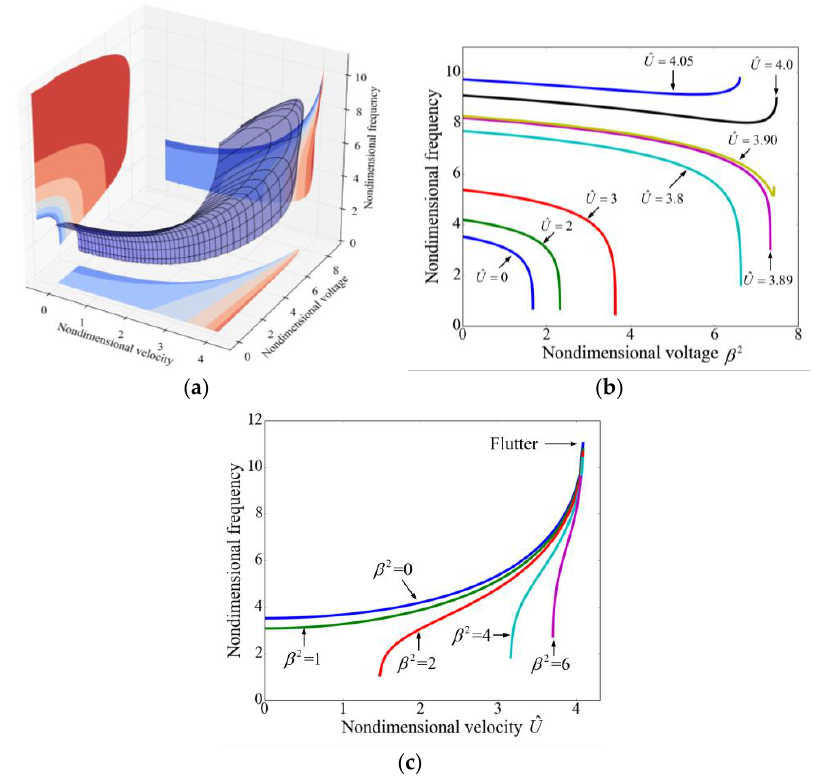
Figure 7. The variation of the fundamental frequency with the nondimensional voltage and the nondimensional velocity. ( a ) The effect of both applied voltage and fluid velocity on the resonant frequency; ( b ) The effect of voltage on the frequency for different fluid velocities; and ( c ) The effect of velocity on frequency for different applied voltages.